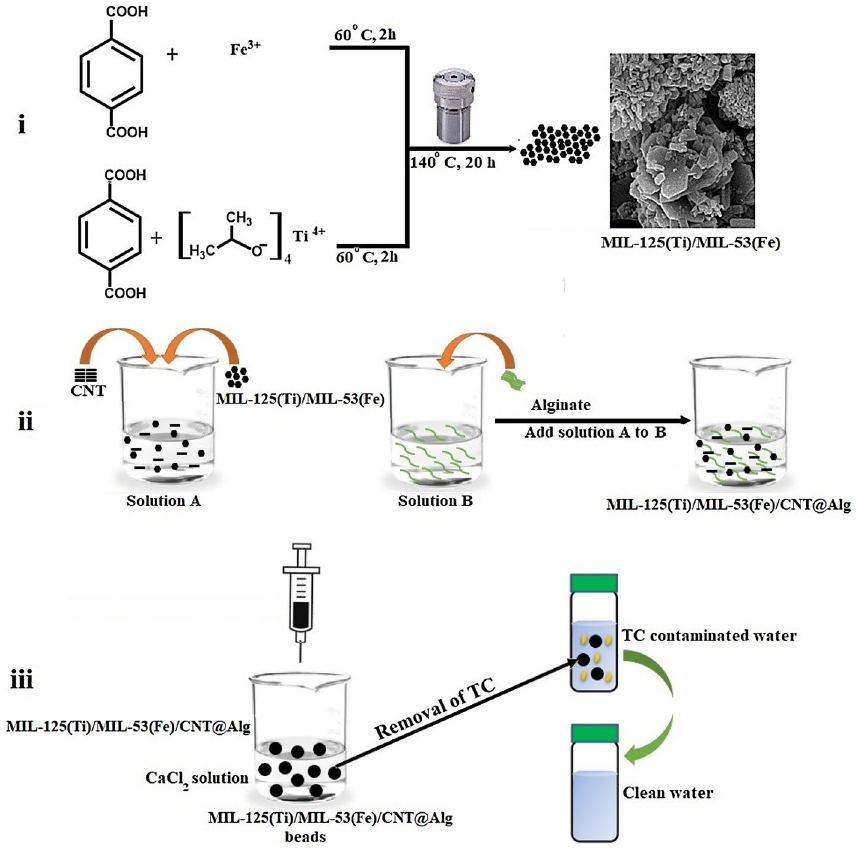
Figure 1. Schematic representation for the fabrication of MIL-125(Ti)/MIL-53(Fe)/CNT@Alg composite microbeads and their adsorption process for TC